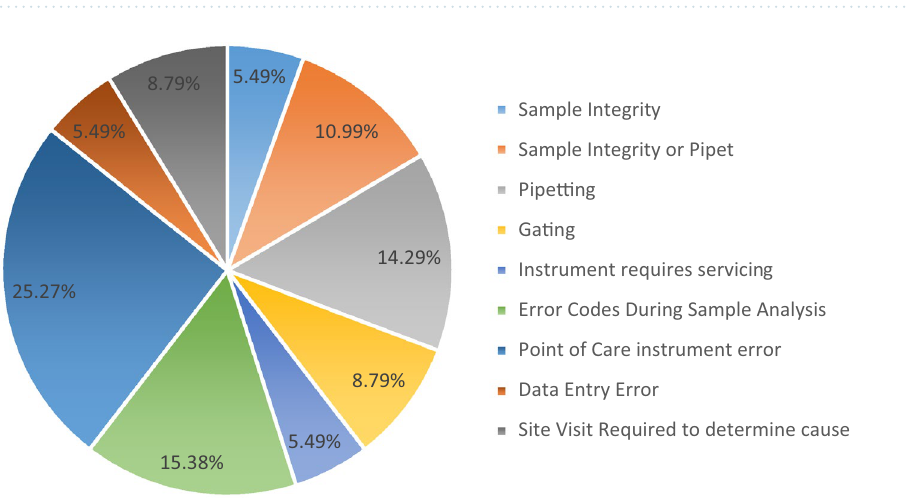
Figure 3. Phase of failures present across sessions. The data here do not include those who were unable to report. This figure is only based on labs who submitted a result.